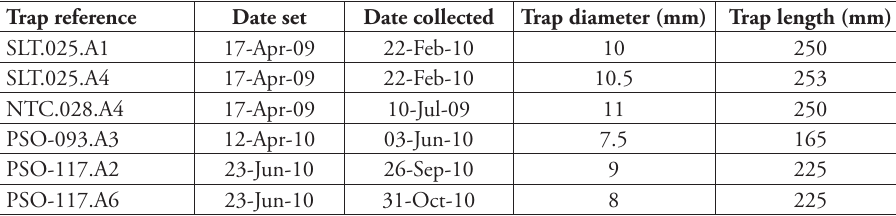
table 1. Trap physical dimensions and dates of Collection. Trap